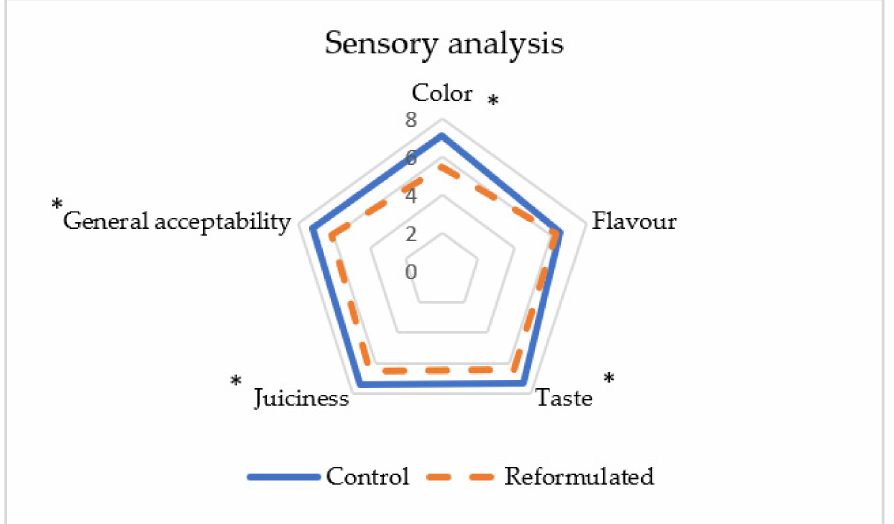
Figure 2. Sensory analysis of control and reformulated cakes. Significant differences ( p < 0.05) between control and reformulated cakes are indicated with an